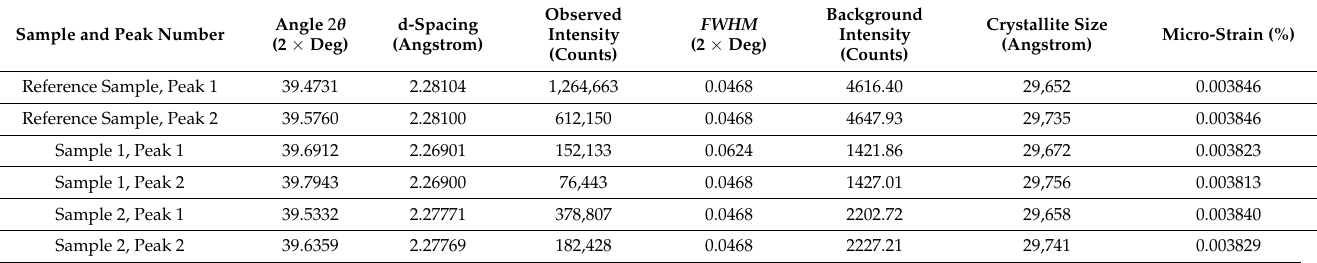
Table 3. The relevant parameters of the fit produced by Empyrean diffractometer’s complimentary analysis software. We note here that the splitting between the two peaks in the same sample is on the order of 0.1 ◦ , and there is a systematic shift of the two most dominant peaks across all 3 samples,